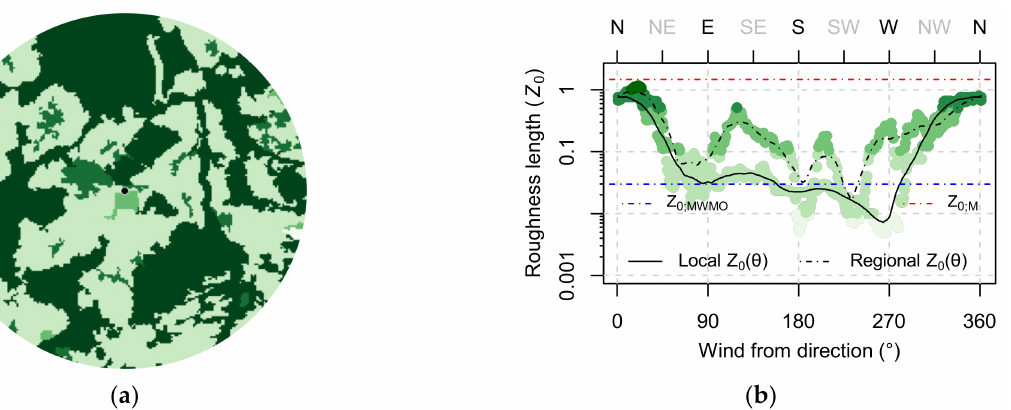
Figure 19. Derived surface roughness for TWINS site ( a ) in 10 km radius adapted from CLC map (© European Union, Copernicus Land Monitoring Service 2018, European Environment Agency (EEA)); ( b ) Directional local and regional surface roughness weighted by distance to building-site. Darker green colour indicates higher surface roughness